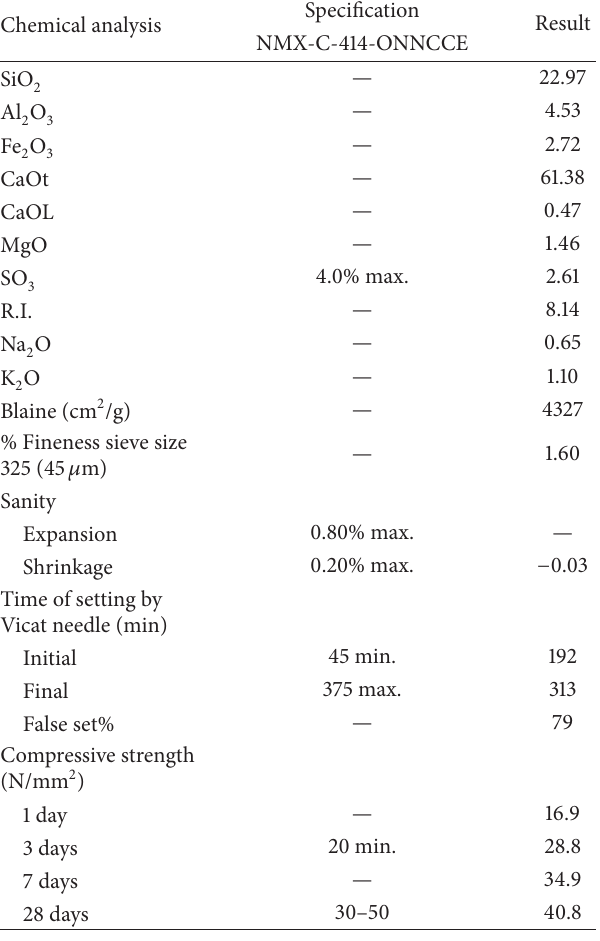
Table 1: Chemical composition and physical and mechanical pro- perties of the cement